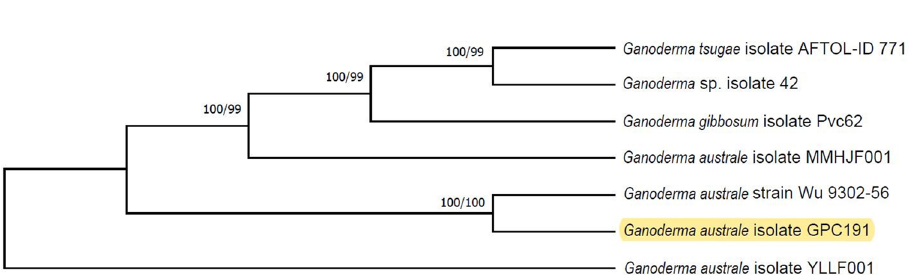
Figure 4. Phylogenetic tree derived from maximum likelihood and maximum parsimony analysis of gene sequences of G . australe GPC191 (analysed in the study) and of its relatives from GenBank. Bootstrap support values ≥ 70% from 500 replicates of ML and MP analyses are indicated. Phylogenetic tree was prepared using Molecular Evolutionary Genetic Analysis software (MEGA, version 10.1.7, https ://megas oftwa